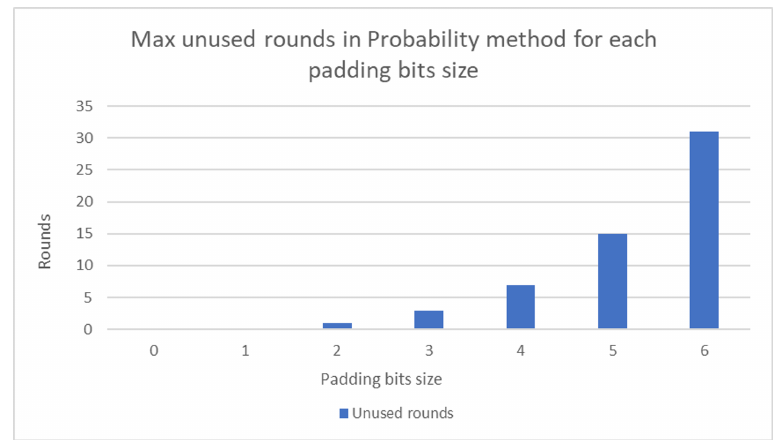
Figure 3. Maximum number of unused rounds for various padding bit sizes.